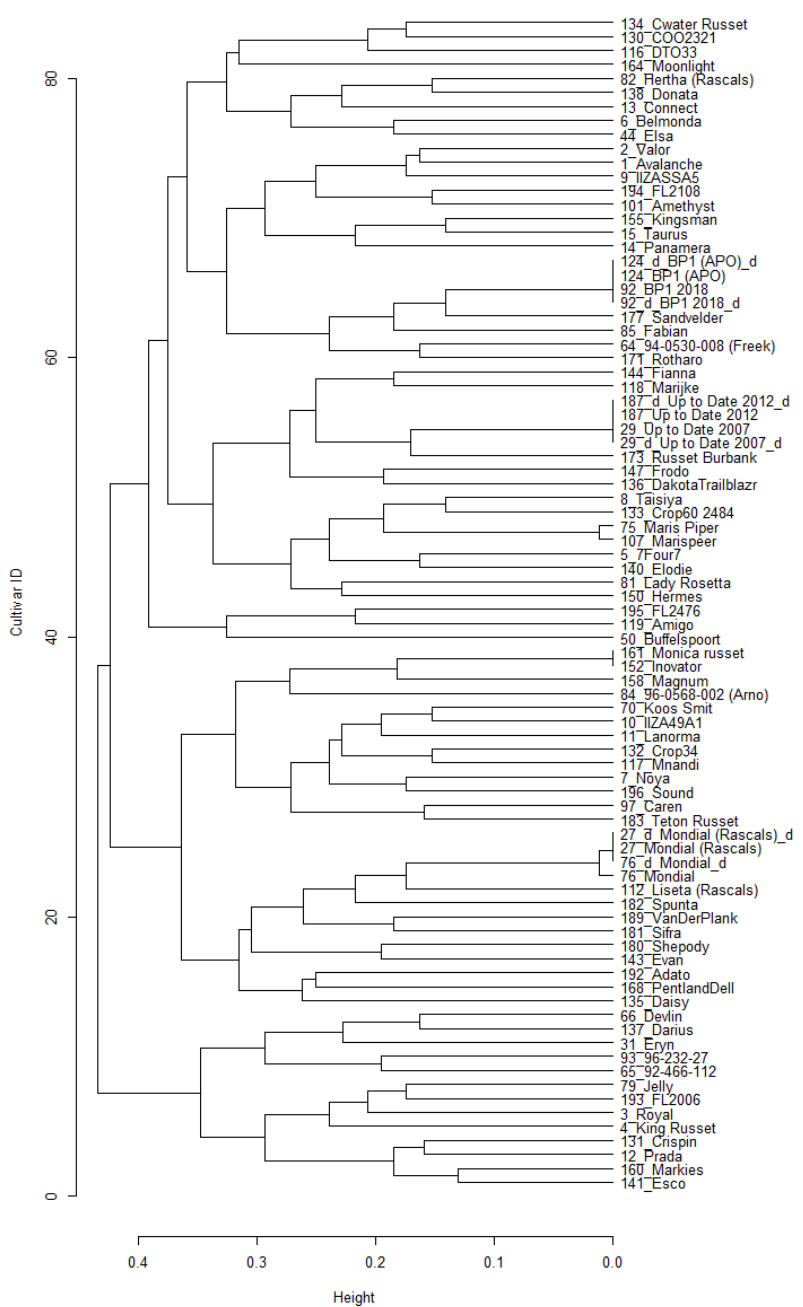
Figure 5. A complete cluster dendrogram of pairwise genetic distances of 78 selected commercially important cultivars genotyped with the 23 successful KASP SNP assays. Genetic distances were calculated with the Kosman index. Six cultivars were duplicated as indicated with “d” in their label.